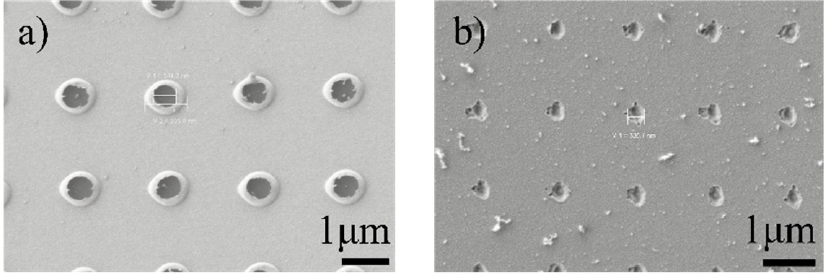
Figure 11. SEM images of periodic nanoholes in ( a ) Au film and ( b ) MgF 2 film ablated by femto- seconds laser with different pulse energy.